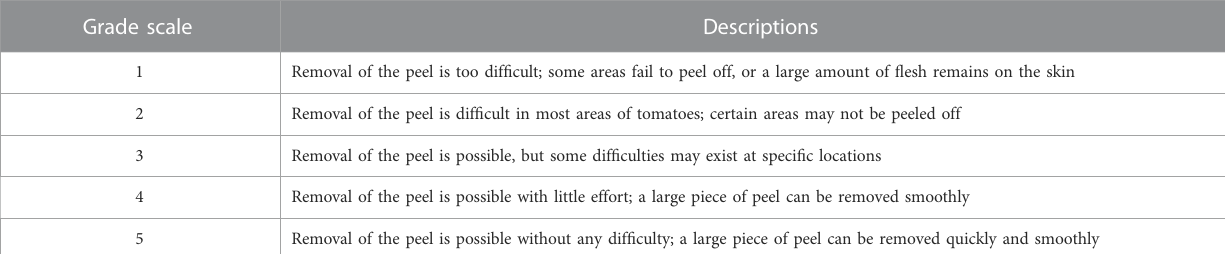
TABLE 1 De fi nitions of the fi ve levels to assess the peeling ability based on Li et al. (2009). Grade